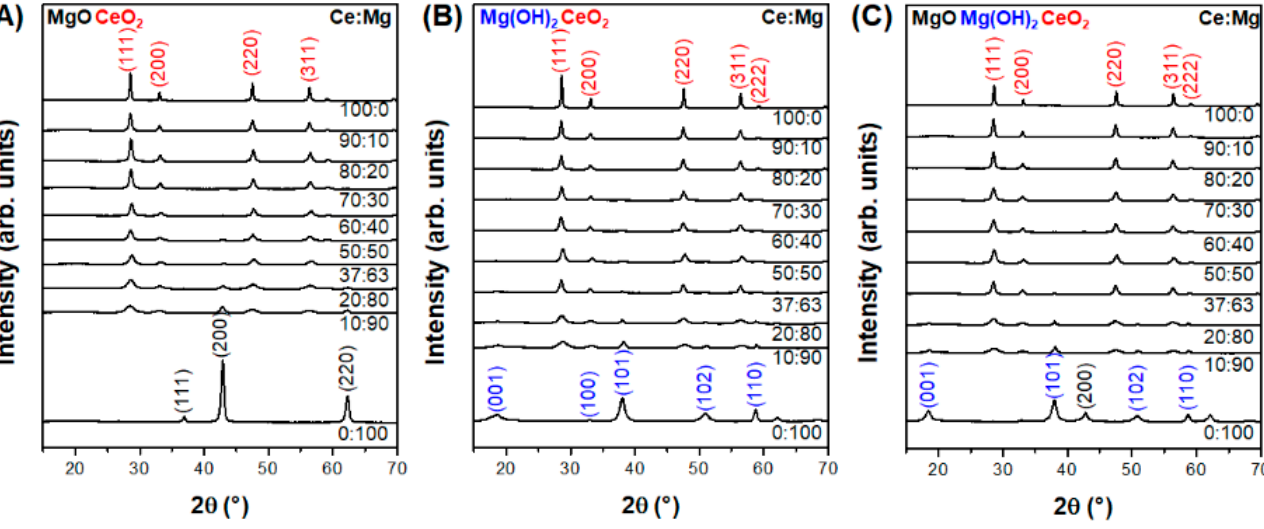
Figure 1. X-ray diffraction patterns of ( A ) as-synthesized CeO 2 –Mg(OH) 2 with different Ce:Mg ratios in the synthesis gel, ( B ) Au-supporting CeO 2 –Mg(OH) 2 before H 2 treatment, and ( C ) Au-supporting CeO 2 –Mg(OH) 2 after H 2 treatment. The CeO 2 –Mg(OH) 2 supports with different Ce:Mg ratios were calcined at 750 °C before supporting Au nanoparticles. The Miller indices in black, blue, and red correspond to MgO, Mg(OH) 2 , and CeO 2 , respectively. Table 1. Reaction summaries showing the MACR conversion and product selectivity by using the Au/CeO 2 –Mg(OH) 2 catalysts with different Ce:Mg ratios calcined at 750 °C. [a] These results are also graphically represented in Figure 2. Ce:Mg Ratio